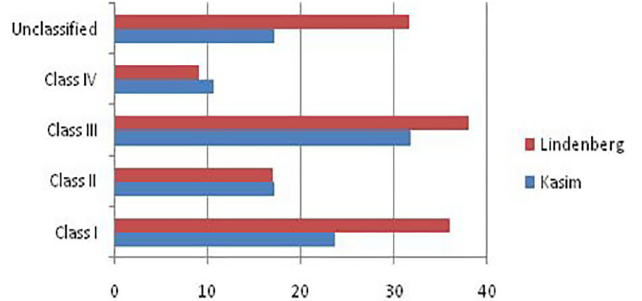
FIGURE 1 - Provisional Classification of drugs present in the 12 th edition of the essential drugs list proposed by Kasim et al . (2004) and Lindenberg, Kopp, Dressman